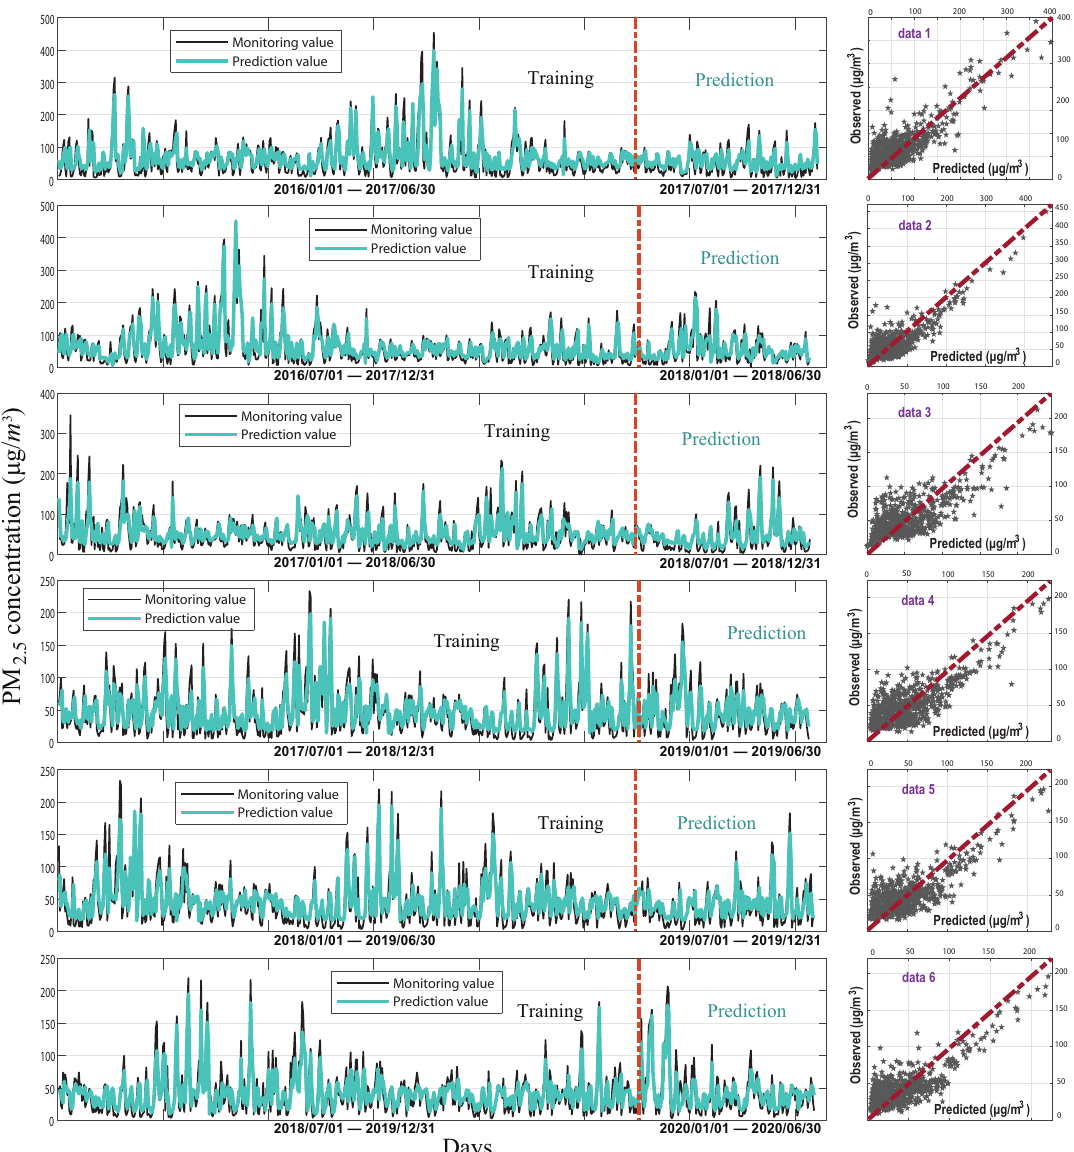
Figure 5. PM 2.5 concentration time series training and prediction results obtained by the SDNN. To further verify the superiority of the SDNN in forecasting PM 2.5 concentrations, a quantitative evaluation is performed. The SDNN is compared to the MLP, DNN-BP, S-DNN, DT, LSTM and SVR models with three different kernels. The overall performances of the prediction models, which are measured by the average value of five estimation metrics for 30 repeated experiments, are summarized in Tables 8 and 9. The optimal values are marked in bold. To detect significant differences between the SDNN and the other prediction models, the Wilcoxon signed-rank test, which is a nonparametric statistical test, is employed in this section. The p -values are calculated and presented on the right of each evaluation metric in Tables 8 and 9, where “-” denotes “not applicable”. The